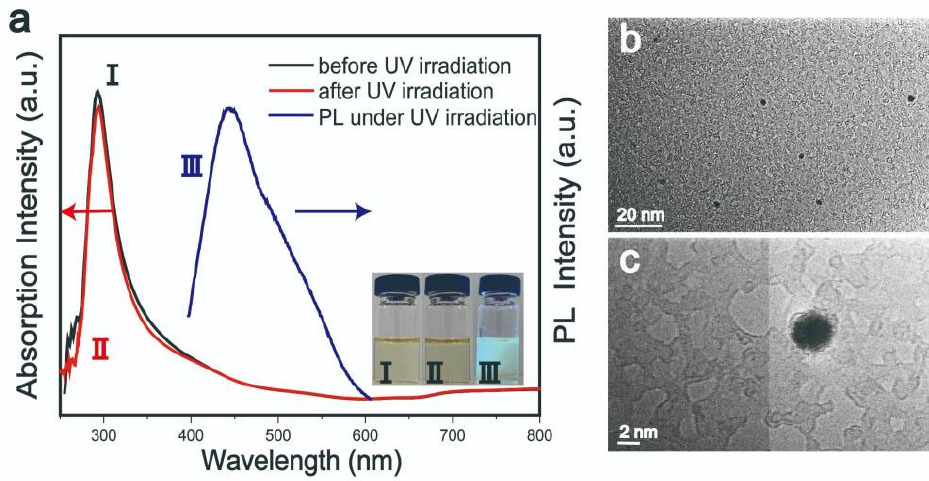
Figure 3. ( a ) UV ‐ visible absorption spectra, photoluminescent spectra, and photographs before (I), during ( Ⅲ ), and after UV irradiation (II). ( b , c ) TEM images of MoO 3 QDs with pure NMP as